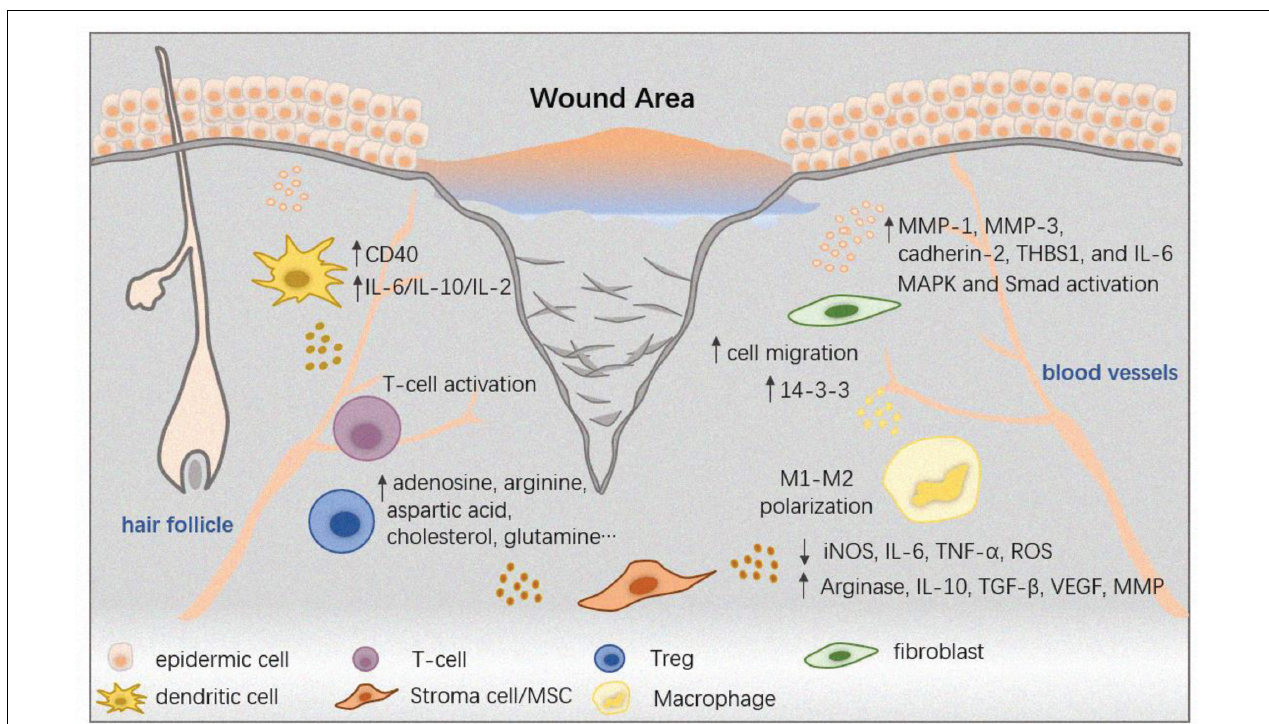
FIGURE 4 | The immunoregulatory roles of exosomes in skin diseases. The skin relies on the immune system for essential functions, such as thermoregulation and infection control. The wound healing process is a complex one with at least three stages, while immune cells participate in them all. Neutrophils and macrophages infiltrate into the wound healing as soon as the inflammatory stage begins. The wound area is a complicated microenvironment that cells inside of it like epidermic cells, fibroblasts, stroma cells can interact with immune cells including T-cells, Tregs, dendritic cells and macrophages by releasing specific bio-molecules, jointly affect the fate of